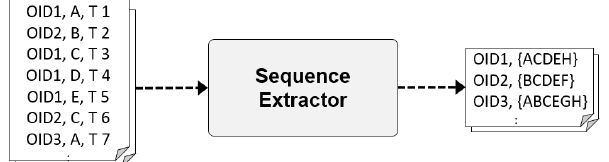
Figure 3. Example of input and output data for Sequence Extractor.